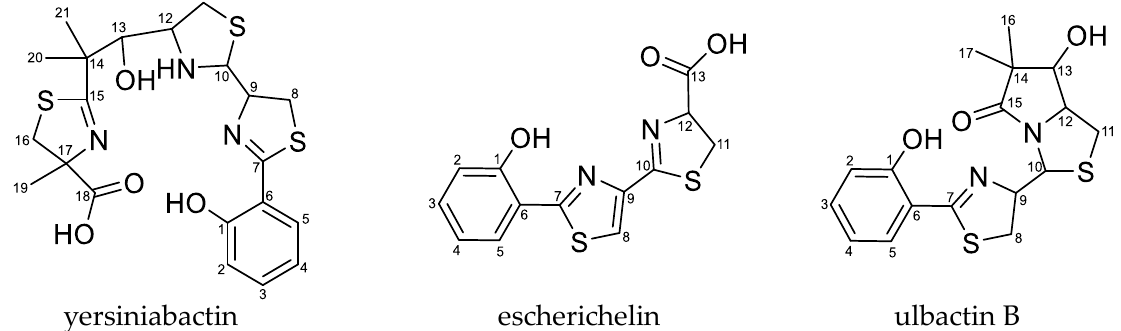
Figure 1. Structure of the siderophores yersiniabactin (Ybt) and escherichelin known for Escherichia coli ( E. coli ) and ulbactin B, which has not been described for E. coli